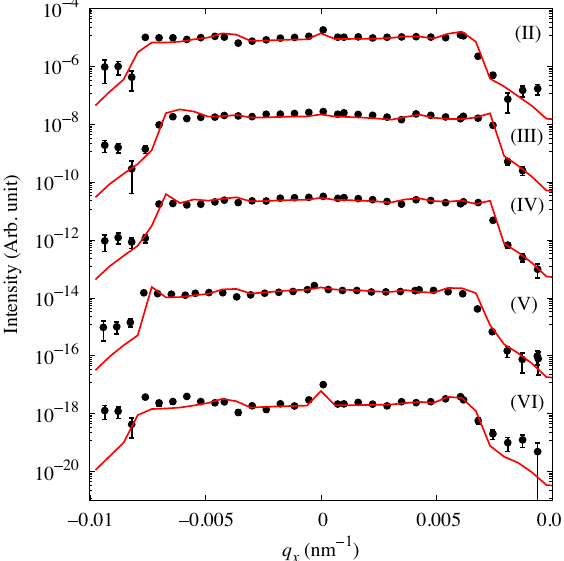
Figure 5. Measured (plots) and simulated (lines) OSS profiles along the condition of α i + α f = 2.5 ◦ ( q z ≈ 0.50 nm − 1 ) in the I − + channel. (II)–(VI) correspond to the measured conditions shown in Figure 2. Each profile is shifted vertically by two orders of magnitude relative to the profile for the immediately previous field for